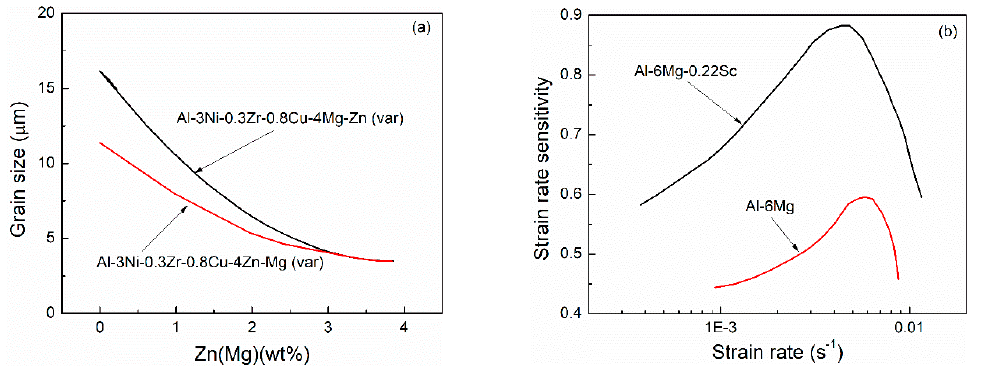
Figure 9. ( a ) E ff ect of concentration of Mg and Zn in alloys, ( b ) e ff ect of addition of Sc in Al-Mg Figure 9. ( a ) Effect of concentration of Mg and Zn in alloys, ( b ) effect of addition of Sc in Al-Mg alloy alloy [117,118].